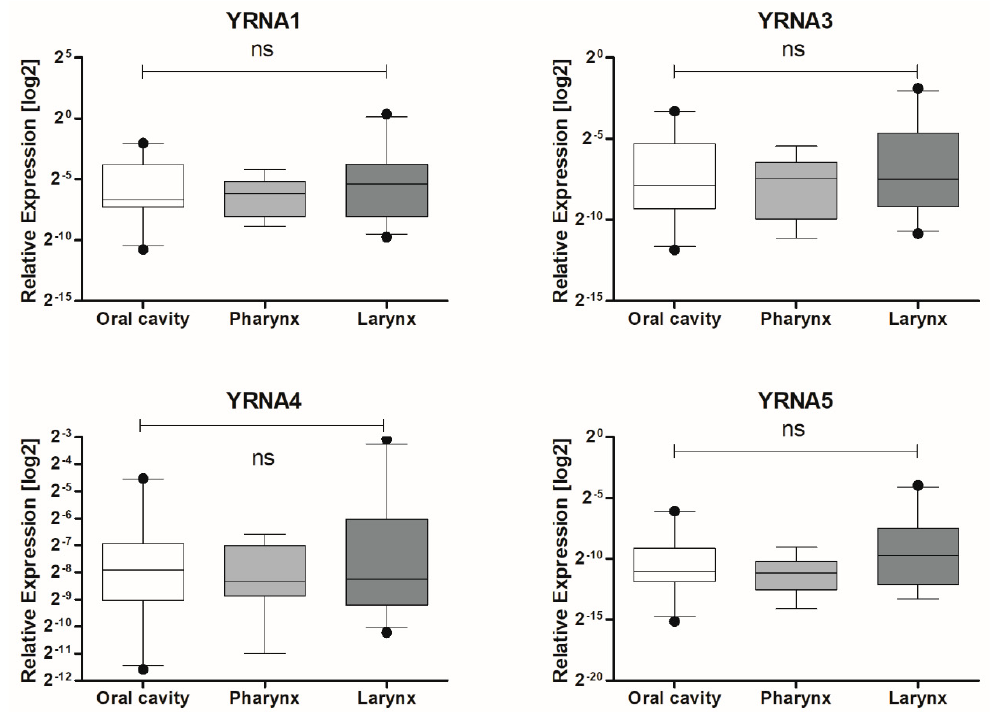
Figure 2. Divided according to the Expression levels of YRNA1, YRNA3, YRNA4, and YRNA5 in patients’ FFPET samples. Three main localizations of HNSCC tumours: oral cavity, pharynx, and larynx; one-way ANOVA with Kruskal–Wallis post-test or Dunn’s multiple comparison post-test; ns—not significant.